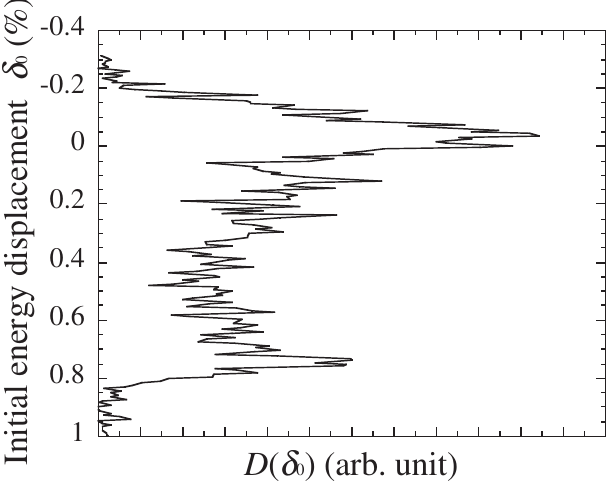
(cid:5) of the linac beam, as recon- 0 (cid:5) of Fig. 3(b) using Eqs. (4) 1